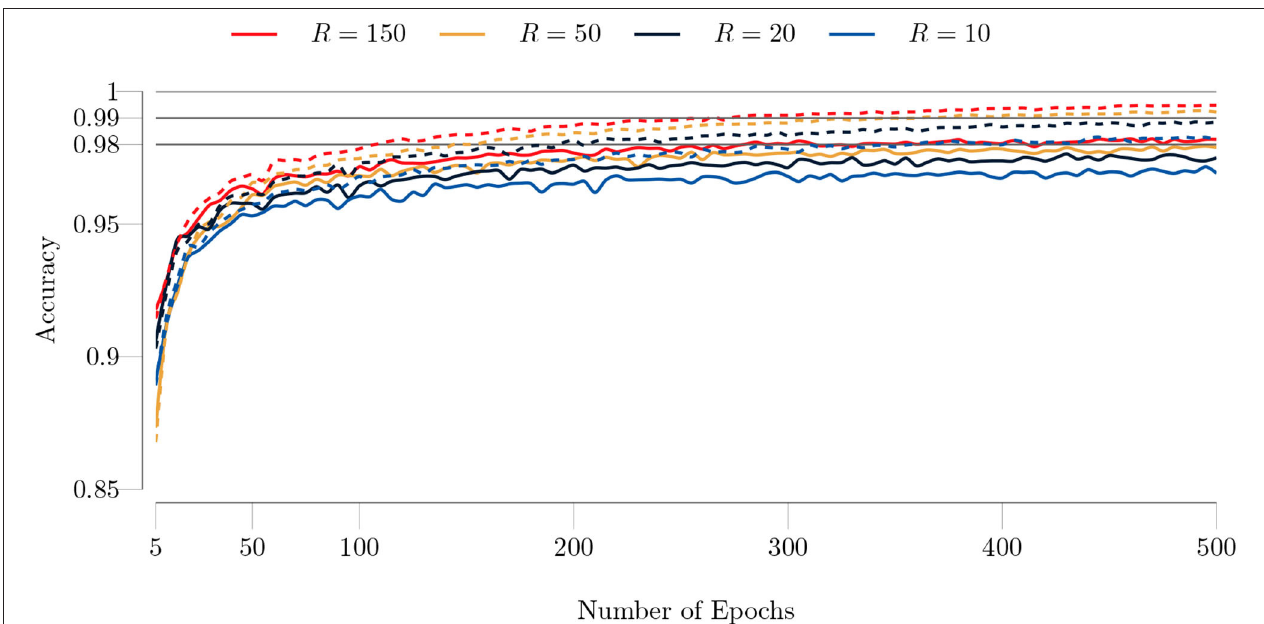
FIGURE 9 | Test (solid lines) and training (dashed lines) accuracies of the type I model for the MNIST dataset with respect to the number of epochs. The full training set (60,000 images) and test set (10,000 images) are used. The batch size is set to 100 and the maximum number of GN iterations is set to 1. TeMPO achieves high accuracy even for low rank values, i.e., R = { 10,20 } . Both the test and training accuracy increase mildly as the rank